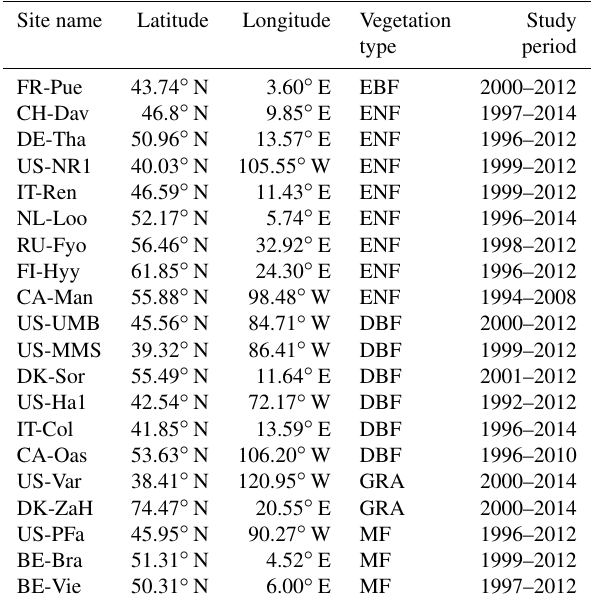
Table 2. FLUXNET sites used in this study. The vegetation types include evergreen broadleaf forest (EBF), evergreen needleleaf for- est (ENF), deciduous broadleaf forest (DBF), grassland (GRA), and mixed forest